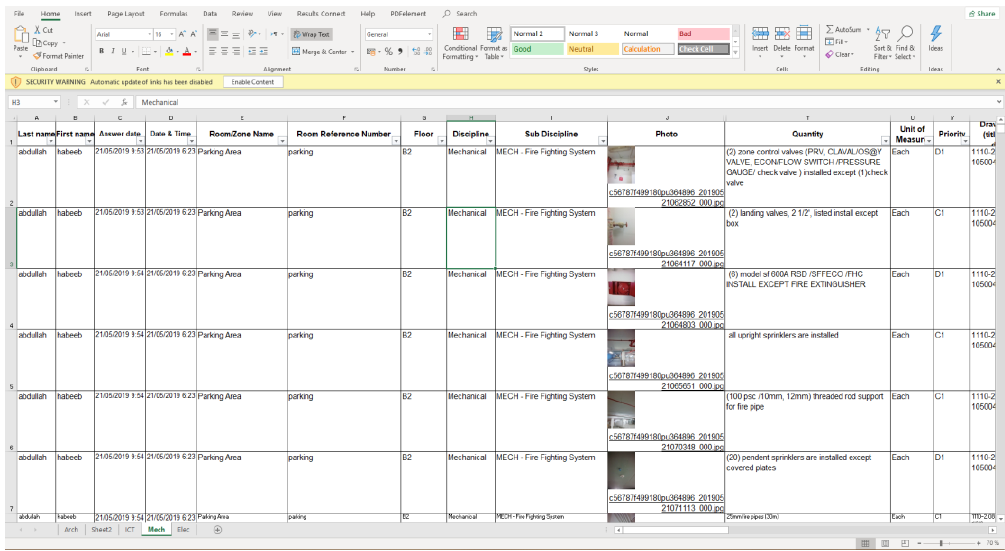
Figure 13: The Final Report Extracted from BIM